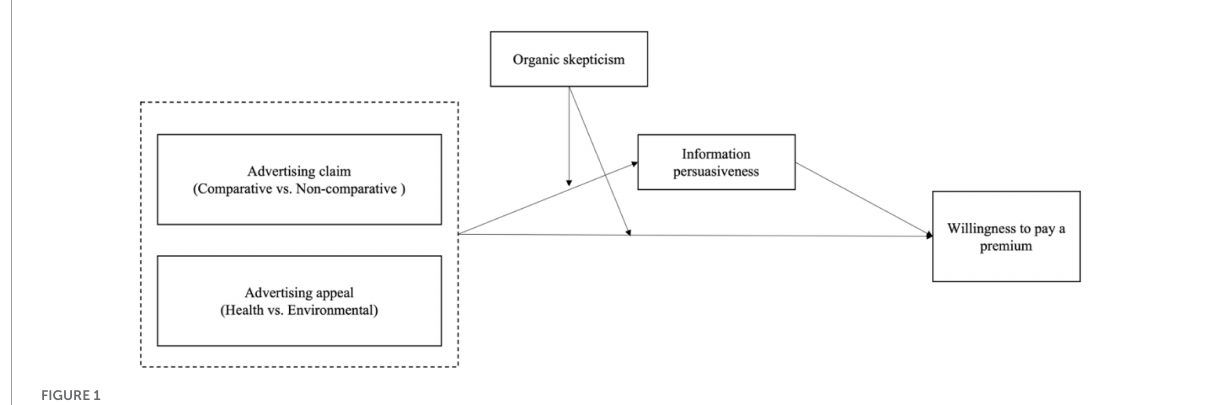
FIGURE1 Theoretical